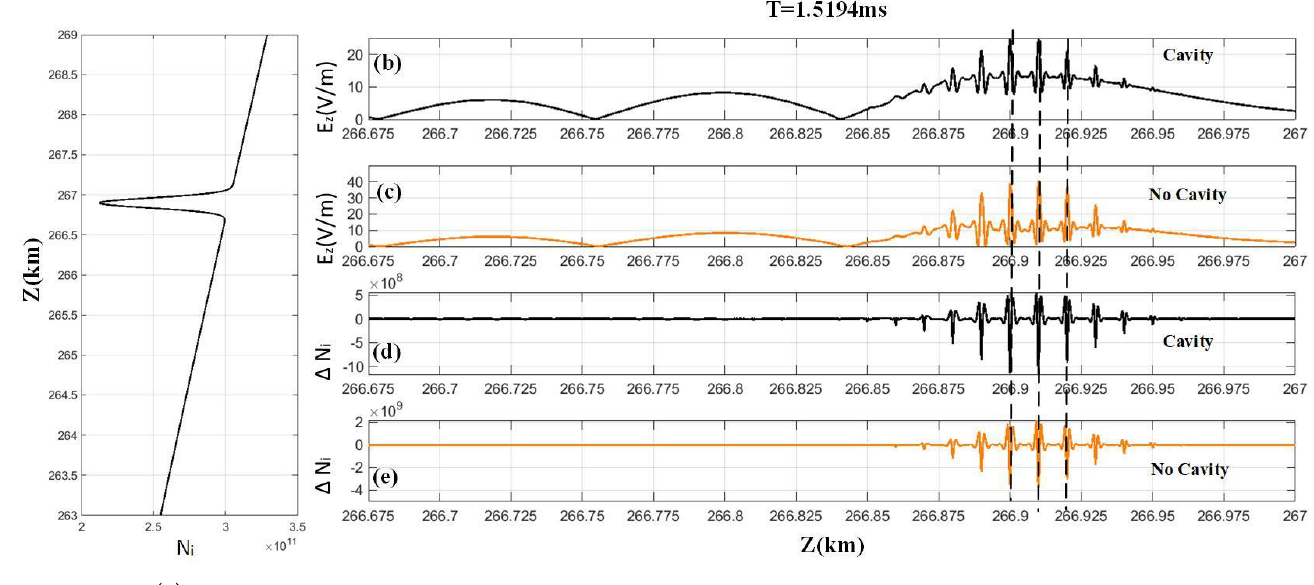
Figure 11. ( a ) Ion density profile with a cavity depth of 15%; ( b , d ) absolute value of the vertical electric field | E z | and ion density perturbation ∆ N i with a cavity depth of 15% in the altitude range of 266.85–267 km at 1.5194 ms; ( c , e ) values without cavity. The spatial Fourier transform of the value of | E z | near the reflection point was per- formed at 1.5194 ms. Figure 12a shows the power spectral density. In this figure, the black line represents that the spatial power spectral density at the cavity depth is 0, and the orange line represents that the spatial power spectral density at the cavity depth is 0.15. Clearly, the power is concentrated around a certain wave number, and the peak values are different when the cavity depths are